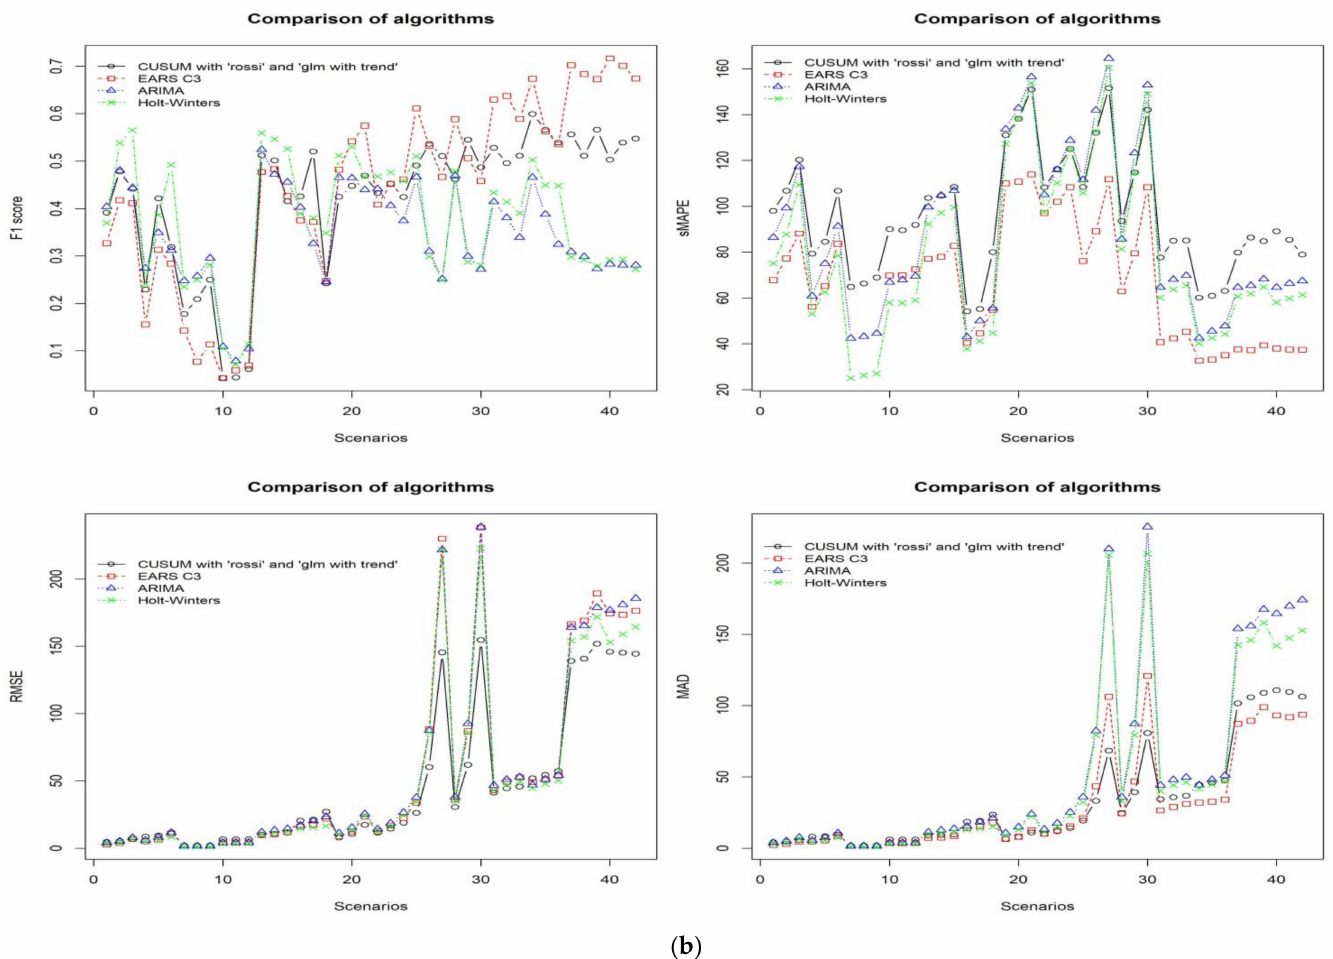
Figure 5. ( a ) The results of comparing CUSUM, EARS C3, ARIMA, and Holt-Winters in terms of sensitivity, specificity, PPV, and NPV across the all scenarios. ( b ) The results of comparing CUSUM, EARS C3, ARIMA, and Holt-Winters in terms of F1 score, sMAPE, RMSE, and MAD across the all